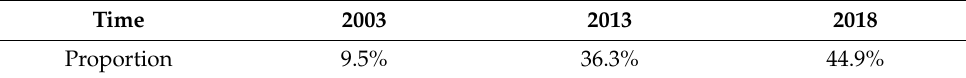
Table 7. Proportion of artificial surface from 2003 to 2018.